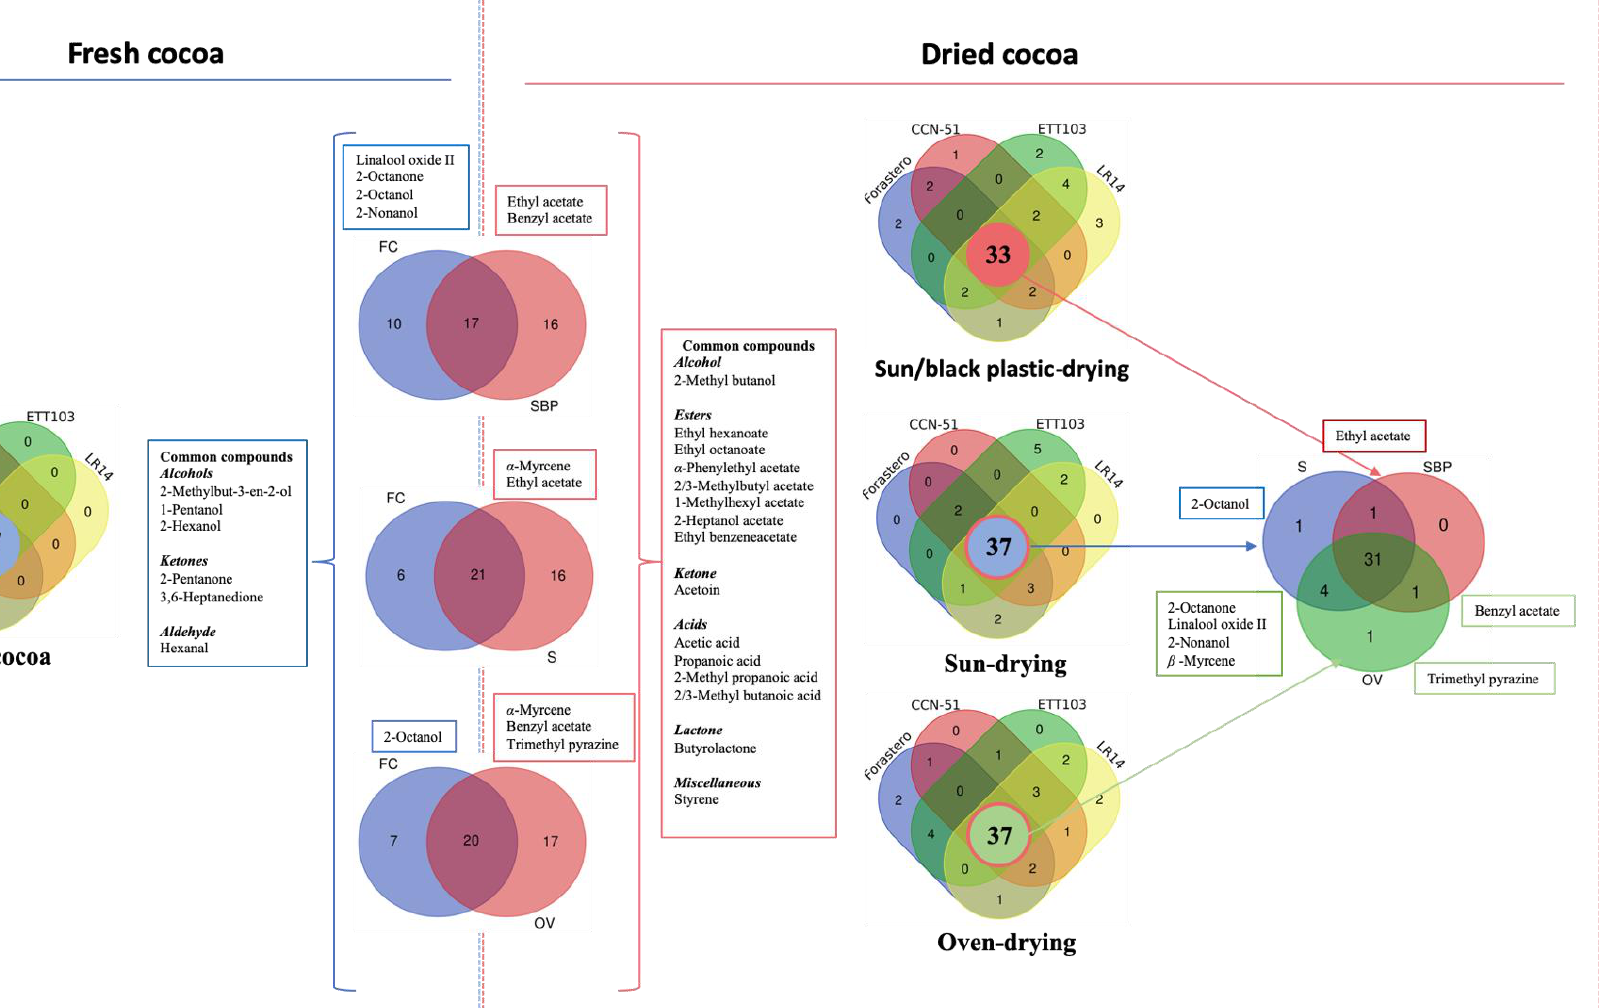
Figure 2. Venn diagrams of volatile compounds from bulk (Forastero and CCN51) and fine-flavor (ETT103 and LR14) cocoa samples in fresh form and after drying by oven, sun, and a modification of sun drying using a black plastic on a concrete floor.